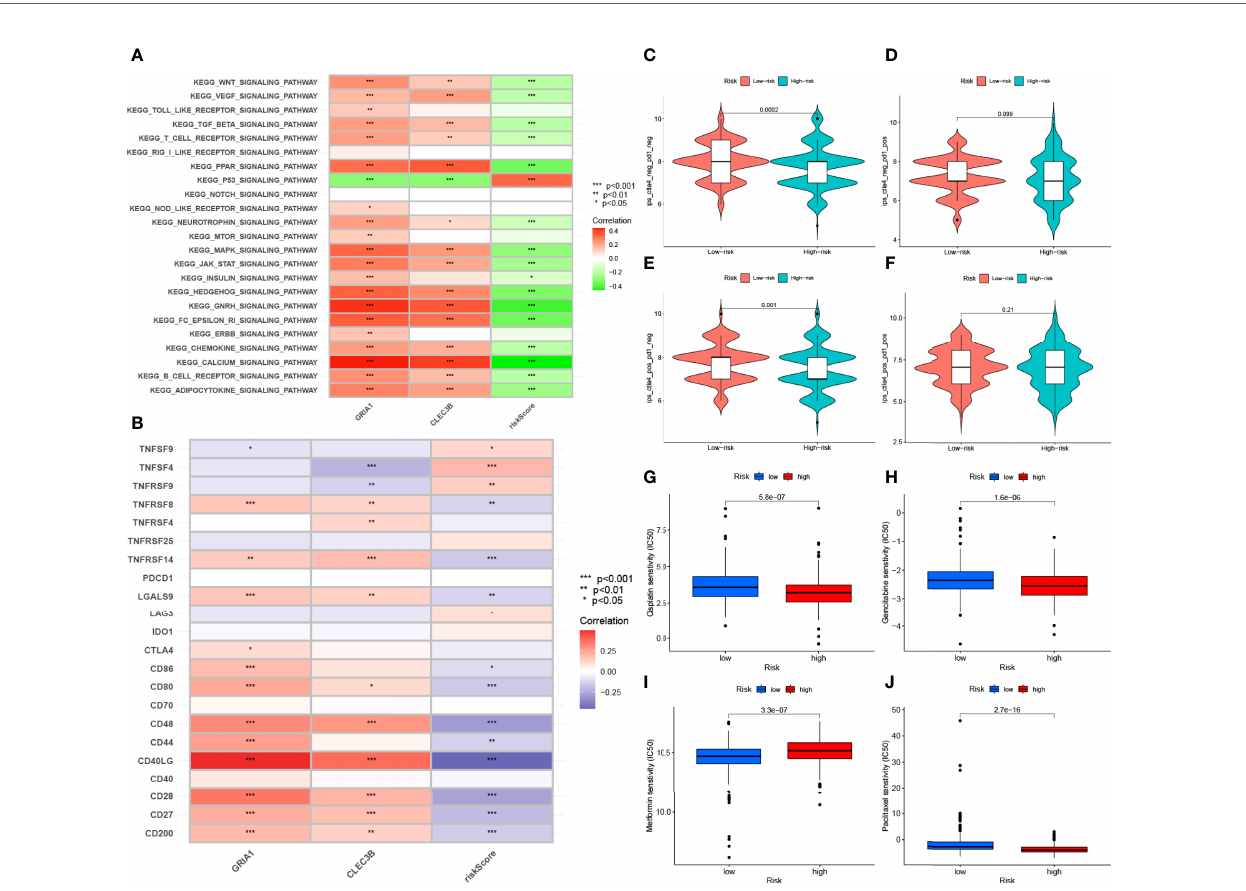
FIGURE 10 | Enrichment pathways for GSVA. (A) heatmap showing the correlation of representative pathway items with KEGG with risk scores. Predicting immunotherapy response. (B) Association of immune checkpoint blockade gene expression levels with risk scores. (C – F) IPS score distribution map. Estimates of chemotherapy effect risk scores. Sensitivity analysis of (G) cisplatin in patients with high and low risk scores. Sensitivity analysis of (H) gemcitabine in patients with high and low risk scores. (I) Sensitivity analysis of metformin in patients with high and low risk scores. (J) Sensitivity analysis of paclitaxel in patients with high and low risk